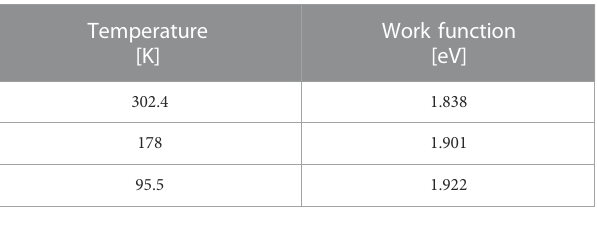
TABLE 2 The work function of the K-Cs-Sb photocathode at different temperatures.